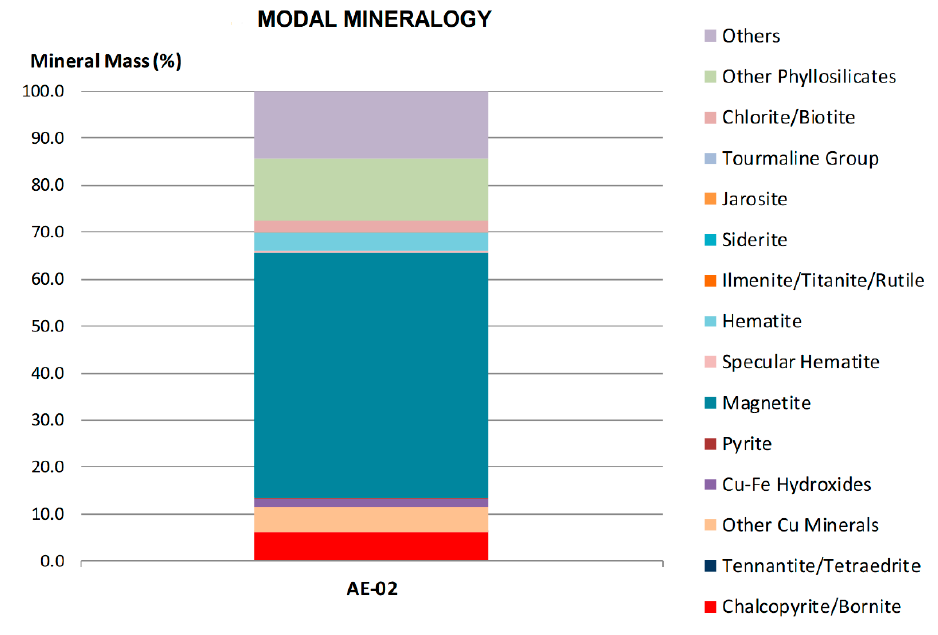
Figure 1. Detailed modal mineralogy. Table 3. The mineralogical composition of the slag as determined by QEMSCAN.